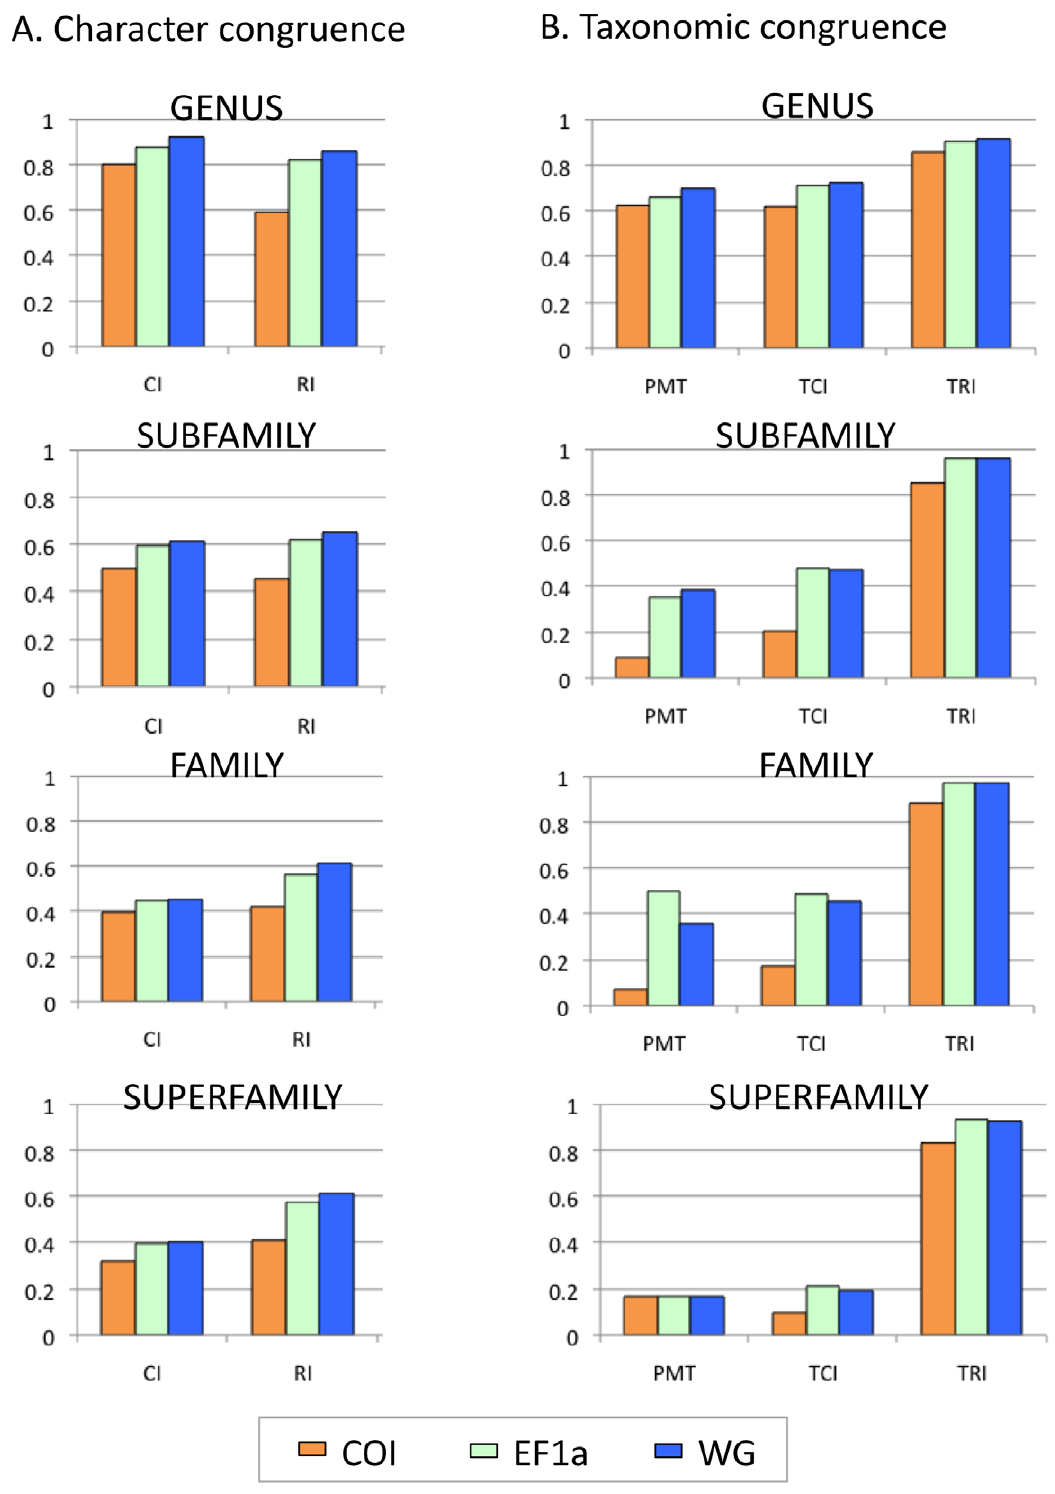
Figure 3. Phylogenetic signal scores. A). Character congruence. Note that lower values of CI and RI indicate more homoplasy in the datamatrix. B). Taxonomic congruence. All abbreviations refer to Table 1; PMT is the proportion of monophyletic taxa, TCI is the taxon consistency index and TRI is the taxon retention index.